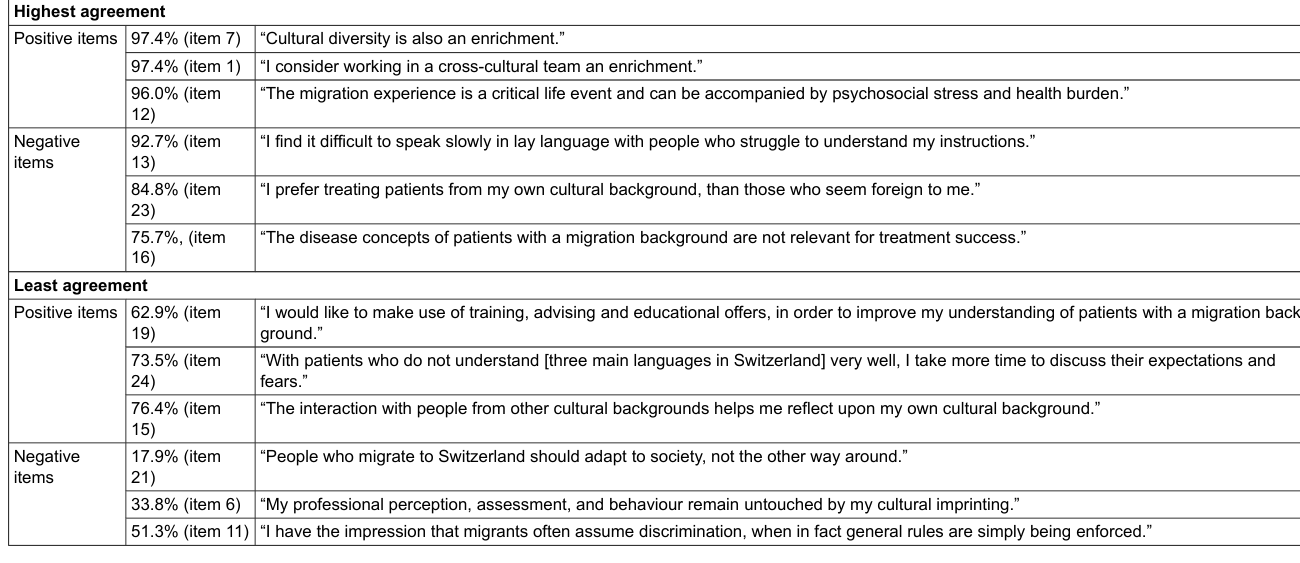
Table 2: Paediatric oncology care providers’ highest and least agreement with individual items. Highest